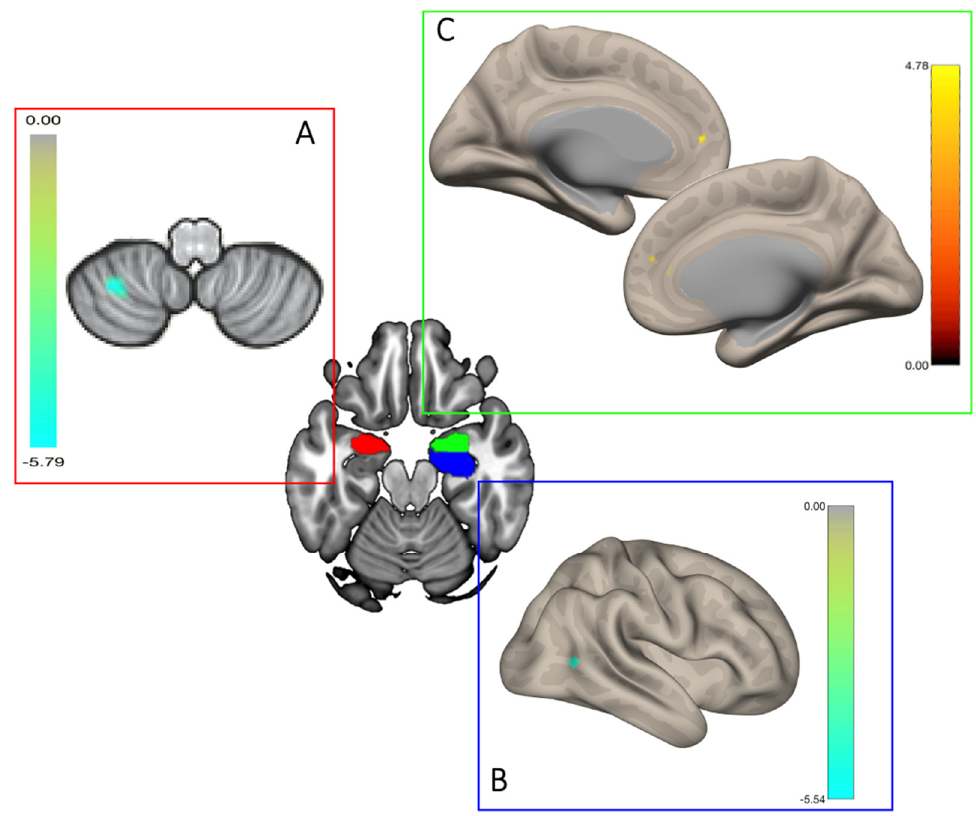
Figure 1. Seed regions are shown in the center, with the left amygdala in red, the right amygdala in green and the right hippocampus in blue. For each region, significant suprathreshold clusters ( p < 0.05 cluster-size p-FDR) are reported in the panel ( A – C ). Clusters of voxels with lower functional connectivity in the UD group are shown in green-to-light blue patches, whereas clusters with higher functional connectivity in the UD group are shown in red-to-yellow patches. Panel A. Functional coupling between the left amygdala and the left cerebellum (lobules VIII). Panel B. Functional coupling between the right hippocampus and the posterior portion of the right middle temporal gyrus on the lateral surface of the brain. Panel C. Functional coupling between the right amygdala and the anterior cingulate cortex on the medial surface of the brain.